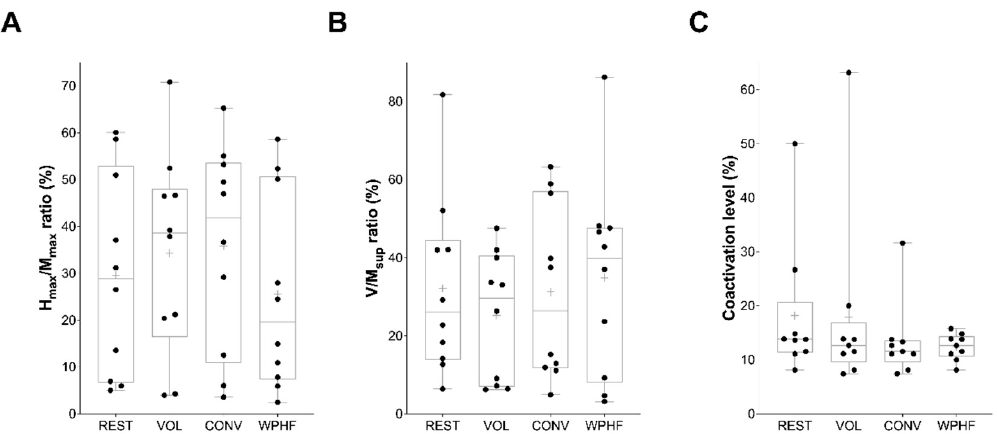
Figure 3. Right leg ( A ) soleus Hmax/Mmax ratio, ( B ) soleus V/Msup ratio and ( C ) tibialis anterior co-